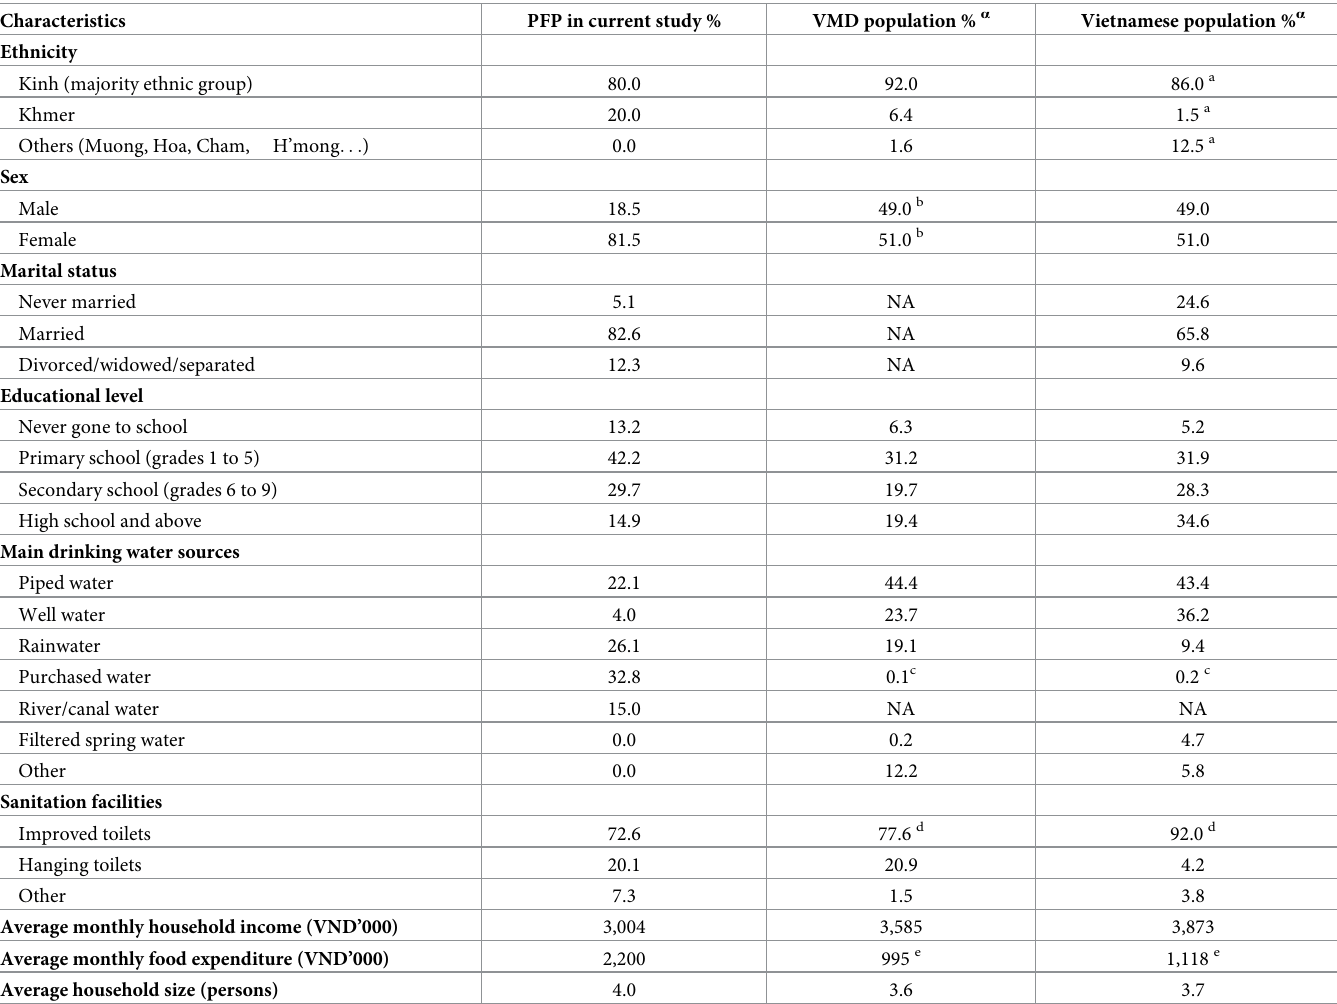
Table 1. Selected socio-economic characteristics, water and sanitation, of the study sample compared with the national and regional population.